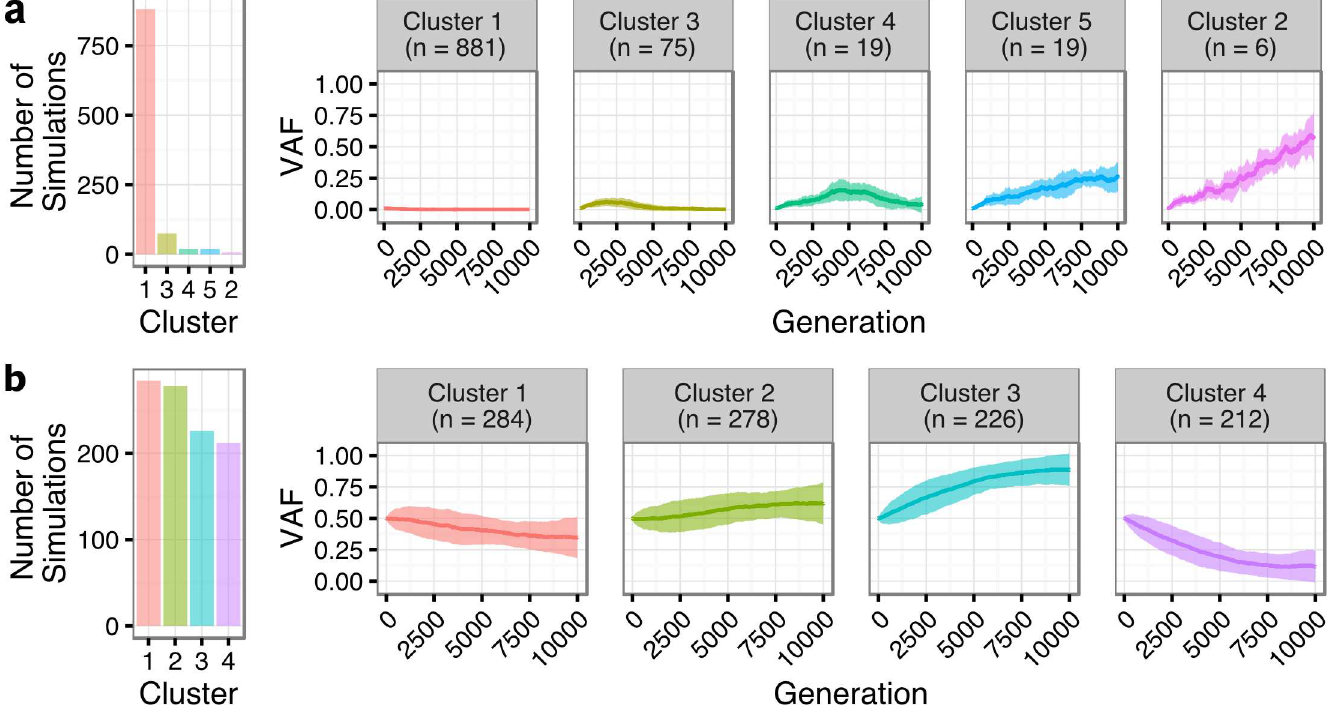
Fig 7. Tumor evolution modeling in transformed and progressed follicular lymphoma patients. Genetic drift modelingin TFL (A) and PFL (B) patients with an initial variant allelefrequency of 1% and 50%, respectively.The far left bar plot indicatesthe number of simulationsthat follow a specific geneticdrift trajectory (shown on the right). PFL, progressed follicularlymphoma; TFL, transformed follicularlymphoma; VAF, variant